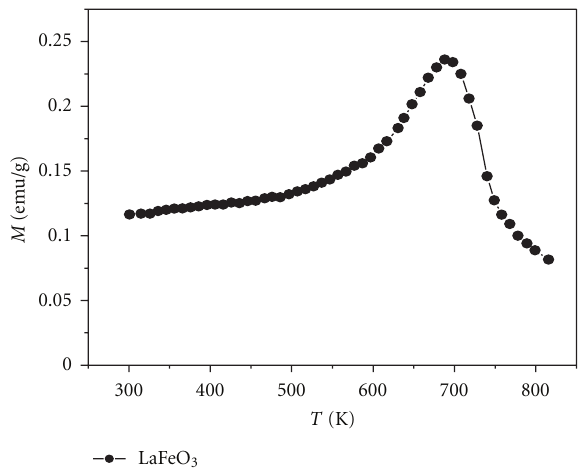
Figure 9: The M ( T ) curve of nano-LaFeO 3 prepared by sol-gel method.